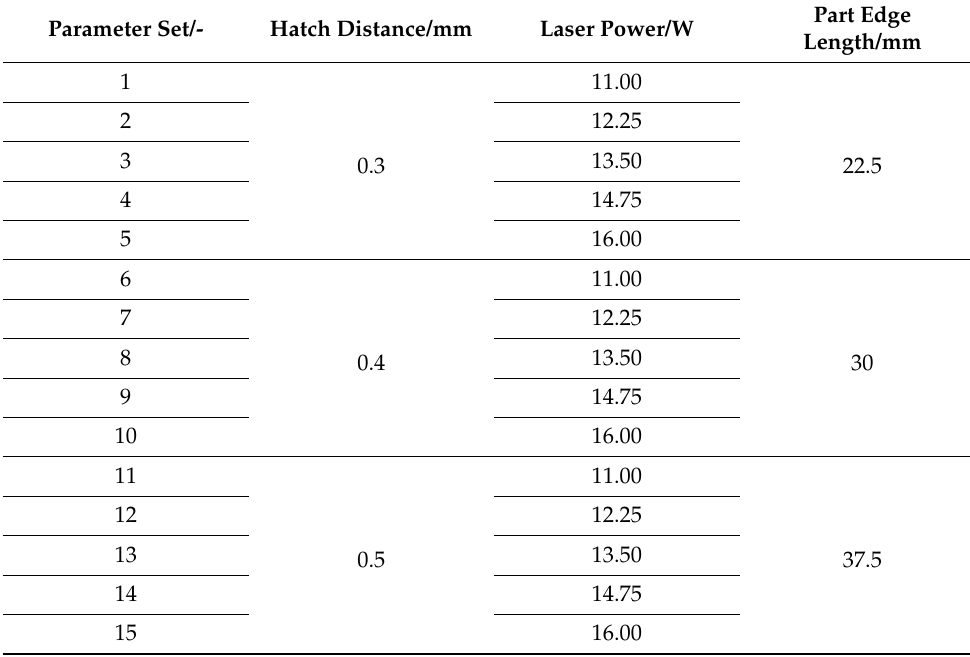
Table 1. Overview of applied processing parameters. Parameter